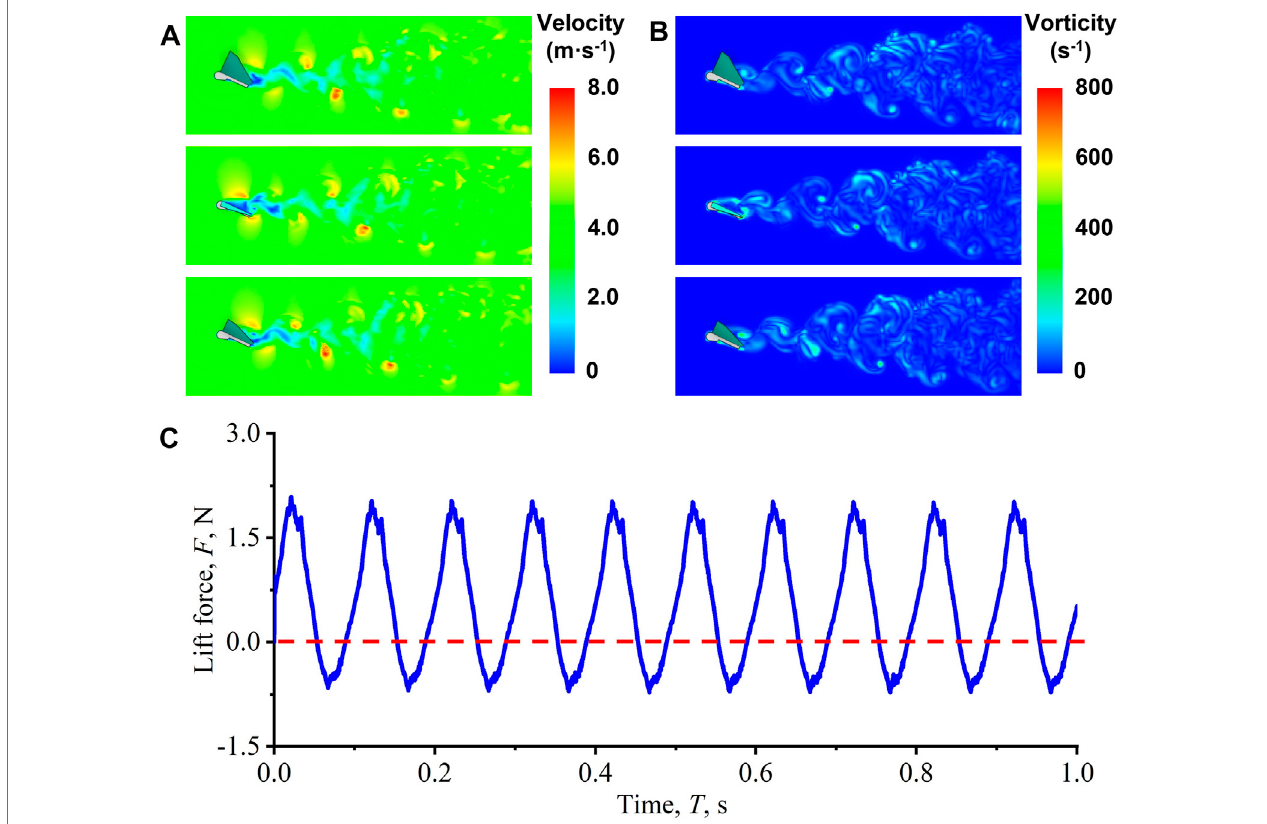
FIGURE 2 | Characterization of the dynamic motion of the FWMAV. (A) Velocity contours of the FWMAV. (B) Vorticity contours of the FWMAV. (C) Simulated lift force of the FWMAV over 1 s.